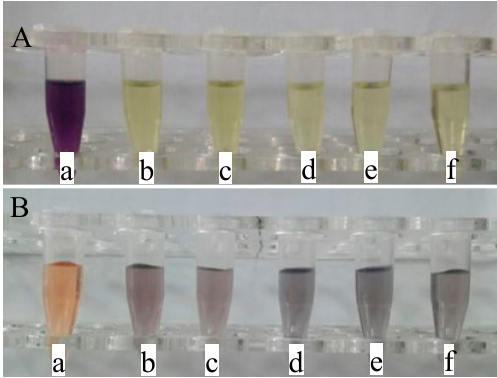
Figure 7. Pictures of color changes of DPPH and hydroxyl free radicals after being treated with PC composite films ( A ) DPPH. ( B ) hydroxyl free radicals.